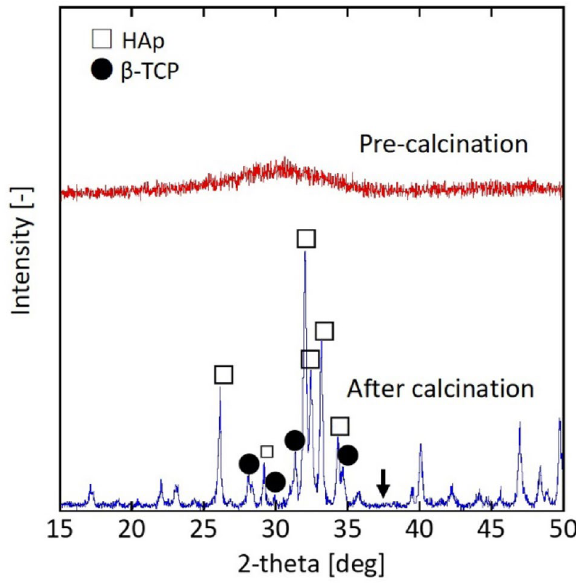
Figure 3. XRD patterns of pre-calcined and calcined particles phosphorylated in the water system using the 1 wt% ACC colloid (Ca/P = 1.67). Arrow denotes the peak position (2 θ = 37.3°) of calcium